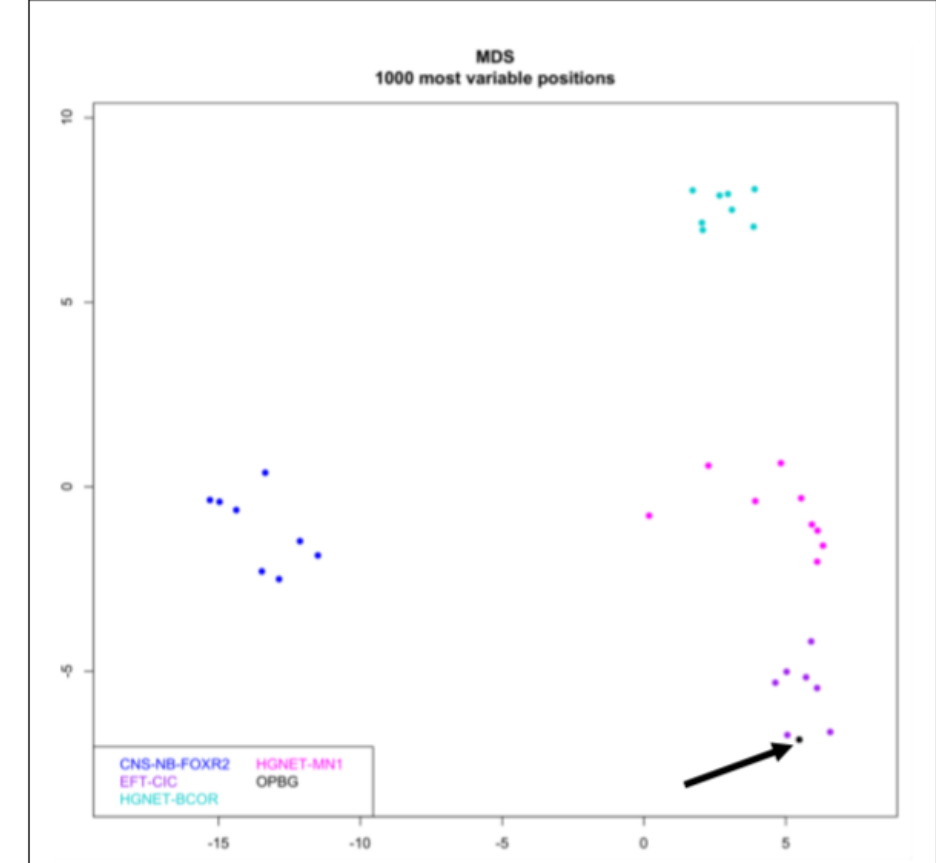
Figure 3. Multidimensional scaling (MDS) analysis performed on the 1000 most variable probes of the whole genome DNA methylation data shows a close similarity between the present case (OPBG) and CIC rearranged sarcomas, while clearly separate from other tumor entities. Color legend of the MDS plot as follows: CIC rearranged sarcoma case (black and arrowed); central nervous system neuroblastoma FOXR2 ( CNS-NB-FOXR2 ) (blue); EFT -CIC (violet); high-grade neuroepithelial tumor- MN1 (HGNET -MN1 ) (pink); high-grade neuroepithelial tumor BCOR (HGNET -BCOR )